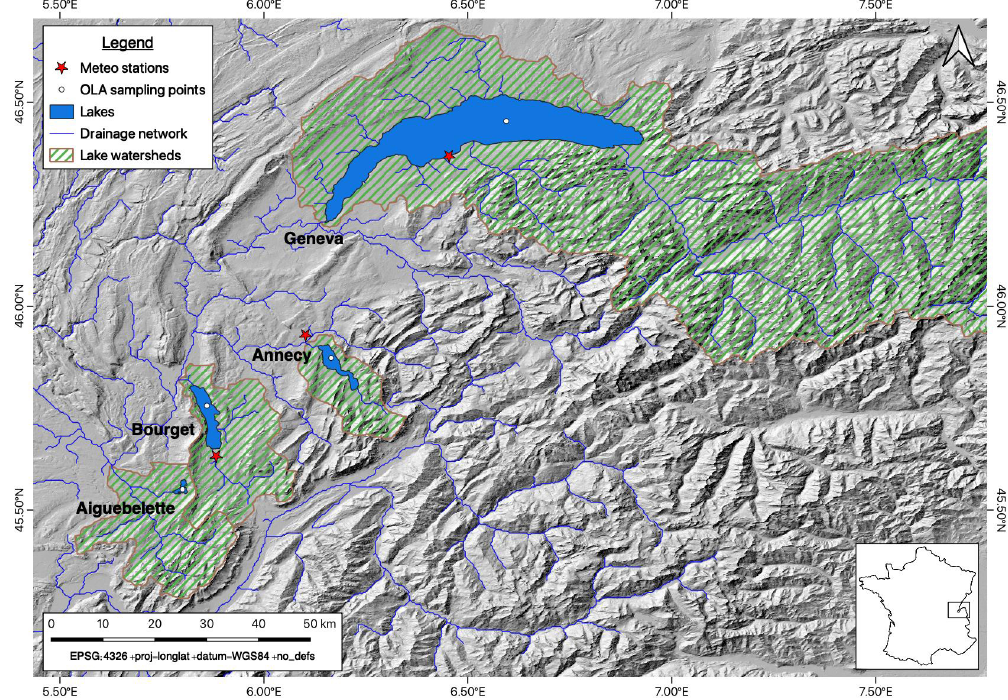
Figure 1. Location of the study sites in the peri-alpine region. OLA sampling sites (Rimet et al., 2020), locations of meteorological stations, drainage watersheds, and networks are represented. Table 1. Characteristics of the four study